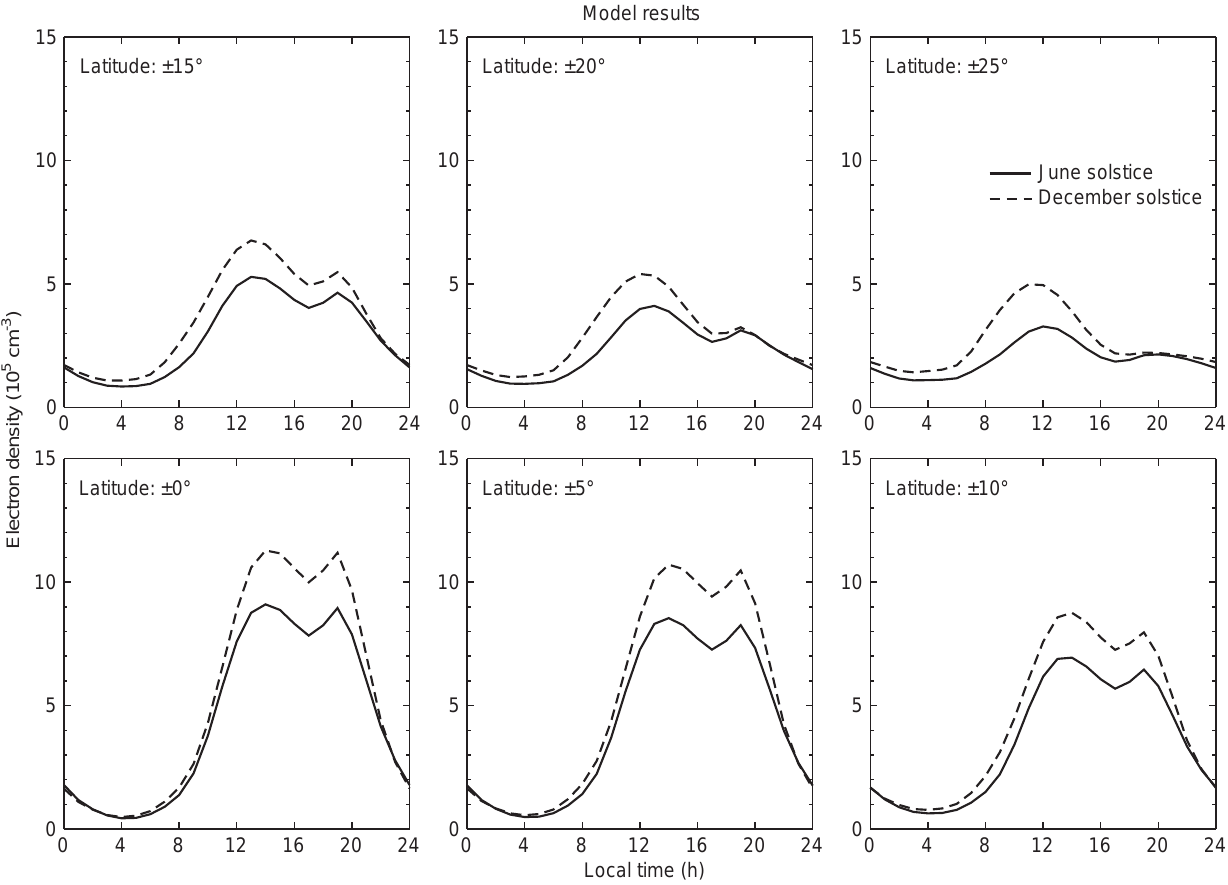
Fig. 6. Diurnal variations of the modelled electron density at latitude 0 (cid:14) , and the averages of the modelled electron densities at latitudes (cid:6) 5 (cid:14) , (cid:6) 10 (cid:14) , (cid:6) 15 (cid:14) , (cid:6) 20 (cid:14) and (cid:6) 25 (cid:14) , for June solstice ( solid curves ) and December solstice ( dashed curves )